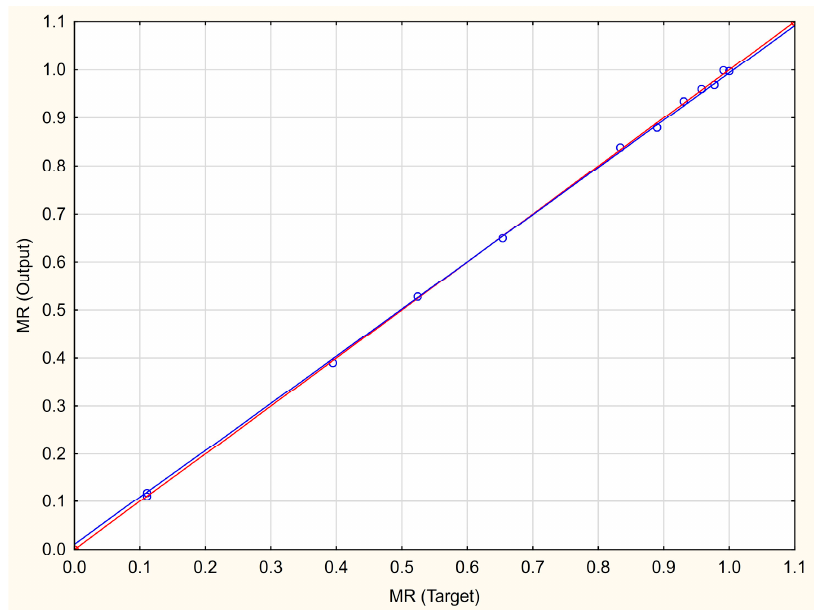
Figure 4. Comparison of fitting of ANN-1 and Weibull model to observed vs predicted values. The ANN-2 network, consisting of 15 neurons in hidden layers, had a performance of 0.999987. The mean square error was 8.03 × 10 − 5 . It can be concluded that artificial neural networks can be successfully used to model the drying process in combination with ultrasound pretreatment. Moreover, both ANNs (Figures 4 and 5) were significantly more accurate than the standard empirical models tested. It should be taken into